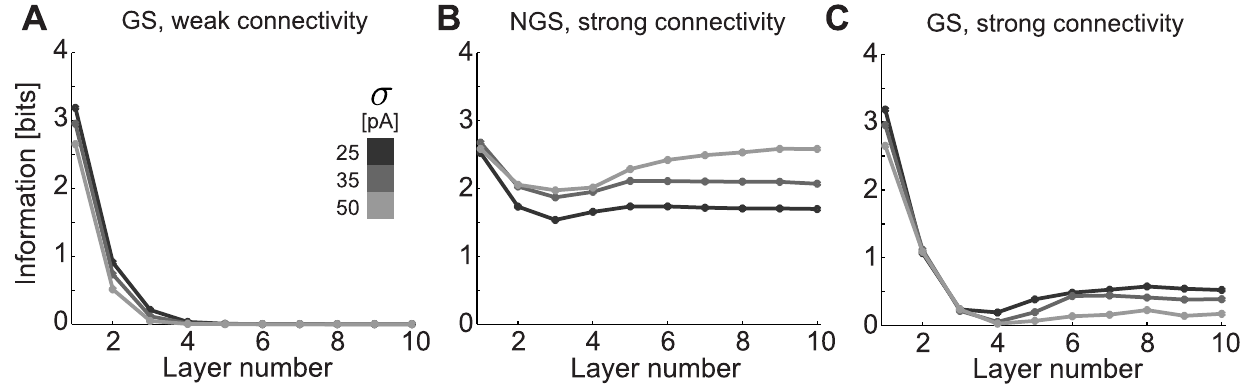
Figure 7. Mutual information about the mean stimulus transmitted by GS and NGS networks. The mutual information as function of layer number for A . weakly connected GS ( G K ~ 1000 pS/ m m 2 and G Na ~ 1500 pS/ m m 2 ), B . strongly connected NGS ( G K ~ 1000 pS/ m m 2 and G Na ~ 600 pS/ m m 2 ) and C . strongly connected GS networks ( G K ~ 1000 pS/ m m 2 and G Na ~ 1500 pS/ m m 2 ) as shown in Figure 6 for different noise levels indicated by the shade of